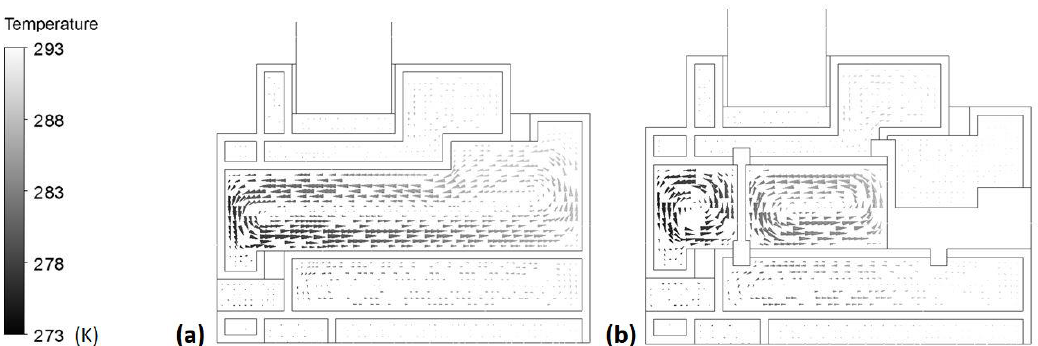
Figure 6. Velocity vectors, colored according to the temperature, showing convection loops for the base fiberglass frame ( a ) and hardware configuration labeled with F6 ( b ). The hardware in section F6 breaks up the large convection loop, resulting in a more insulating frame.